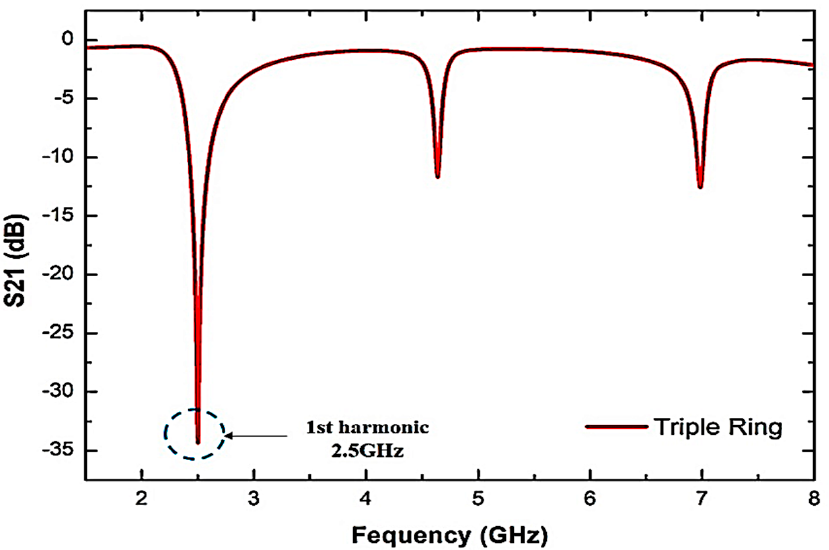
Figure 3. Triple-rings sensor simulated frequency response.